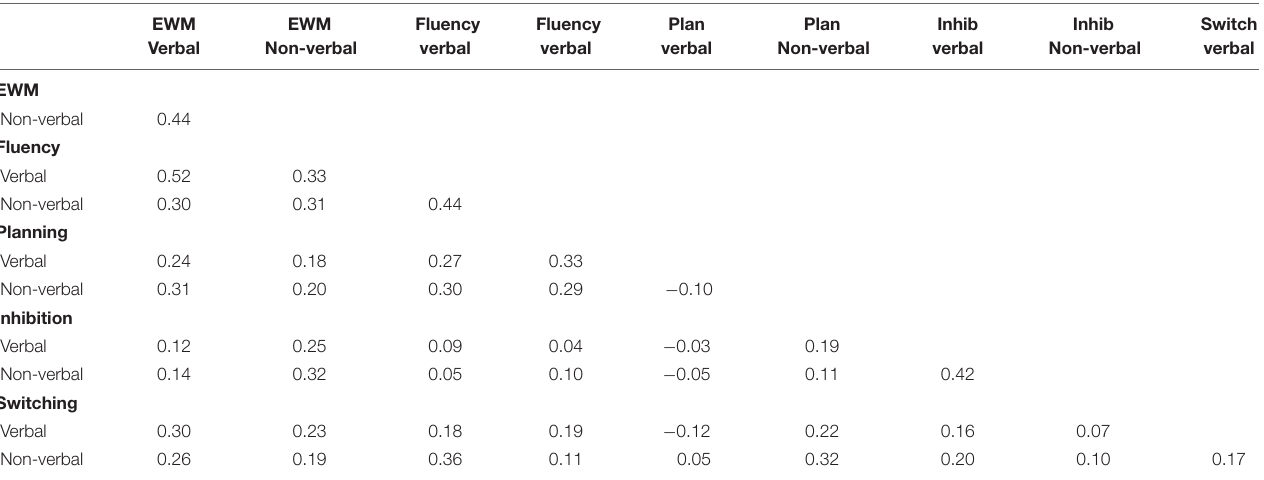
TABLE 2 | Bivariate correlations between EF assessments.